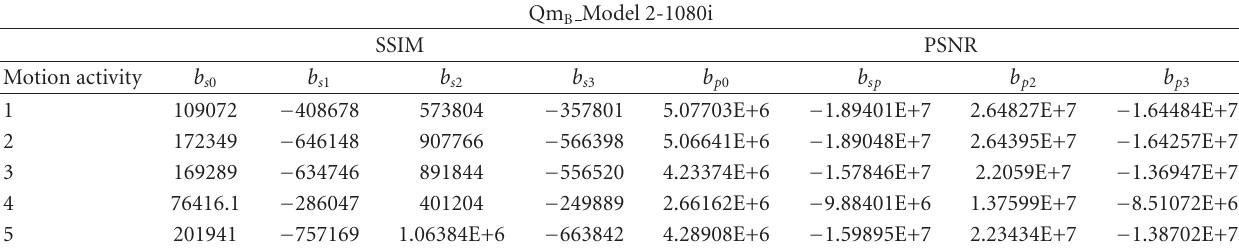
Table 8: Coe ffi cients for the second model of Qm B .